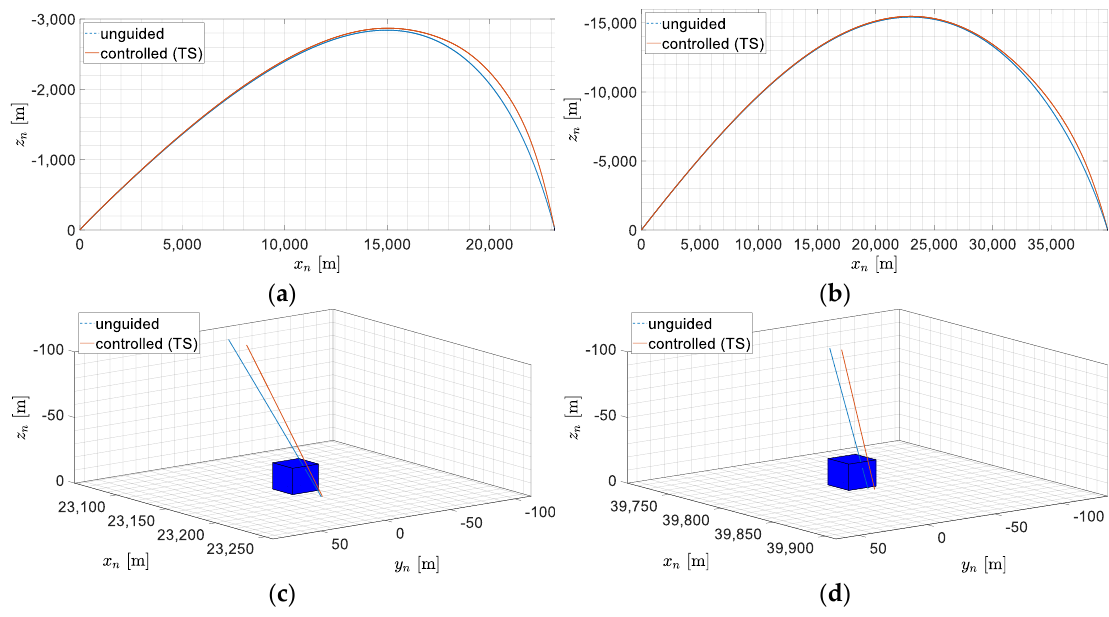
Figure 11. Trajectory shaping capabilities: altitude / cross-range vs. range ( a ) Θ 0 = 20 ◦ ( b ) Θ 0 = 50 ◦ Figure 11 . Trajectory shaping capabilities: altitude/cross-range vs. range (a) 𝛩 0 = 20° (b) 𝛩 0 = 50° terminal phase ( c ) Θ 0 = 20 ◦ ( d ) Θ 0 = 50 ◦ terminal phase (c) 𝛩 0 = 20° (d) 𝛩 0 = 50°